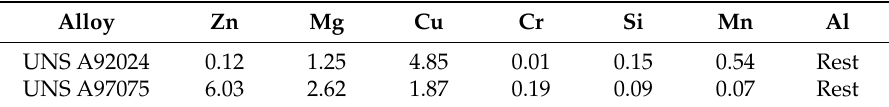
Table 1. Composition of machined alloys